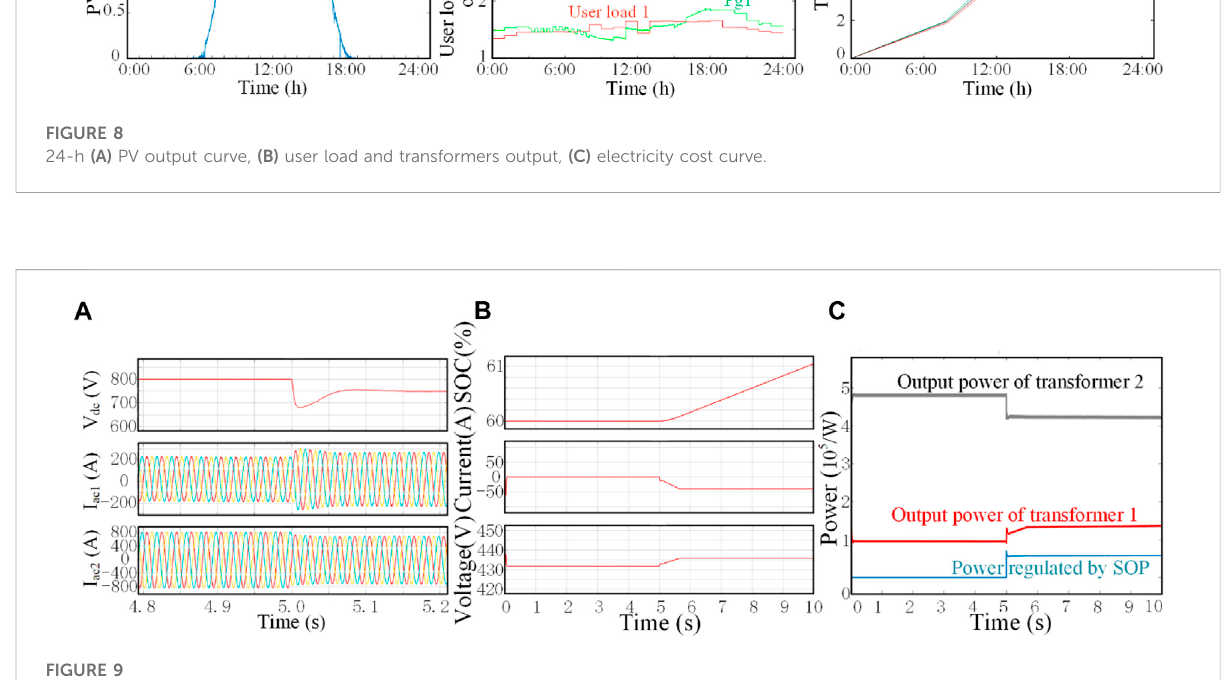
FIGURE 9 (A) DC link voltage and AC/DC converters regulation waveform, (B) State change waveform of BESS, (C) Power variation diagram within the system.